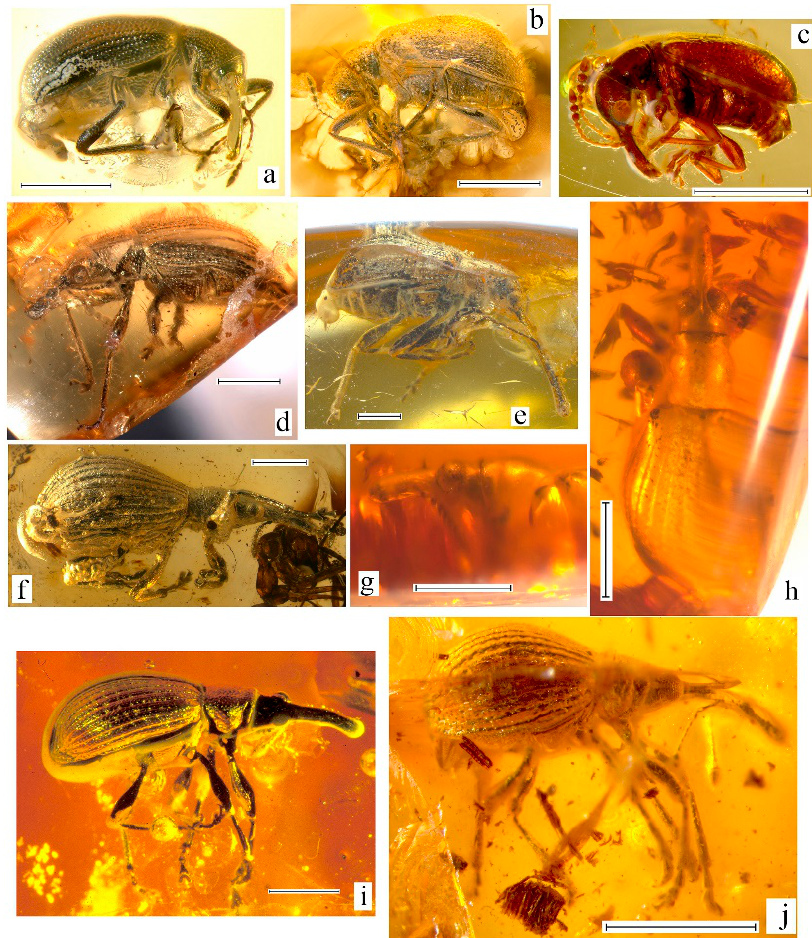
Figure 4. Habitus of Rhynchitidae and Brentidae from Baltic amber. ( a ) Baltocar ho ff einsorum , specimen, ISEA , no. 2012 / 14, body, laterally. ( b ) B. convexus , holotype, ISEA , no. BA2013 / 3, body, laterally. ( c ) Electrauletes unicus , holotype, ISEA , no. BA2014 / 1, body, laterally. ( d ) Succinorhynchites alberti , holotype, ISEA , no. BA2012 / 7, body, laterally. ( e ) Eocenorhynchites vossi , holotype, PIN . no. 964 / 1233, body, laterally. ( f ) Baltocyba electrinus , holotype, ISEA , no. BA2017 / 9, body, laterally. ( g , h ) Archinvolvulus liquidus , holotype, ZMUC , no. 957: fore-body, laterally ( g ); body, dorsally ( h ). ( i ) Baltoapion subdiscedens , holotype, GPIH , no. 196, body, laterally; ( j ) B. gusakovi , holotype, CVGM , no. 023C96, body, laterally. Scale bars: 1.0 mm. See Section 2 for names of collections. 1. Rounded apex of elytra when wings closed. Elytral striae indistinct or absent. . . . . . . . . . . . . . .